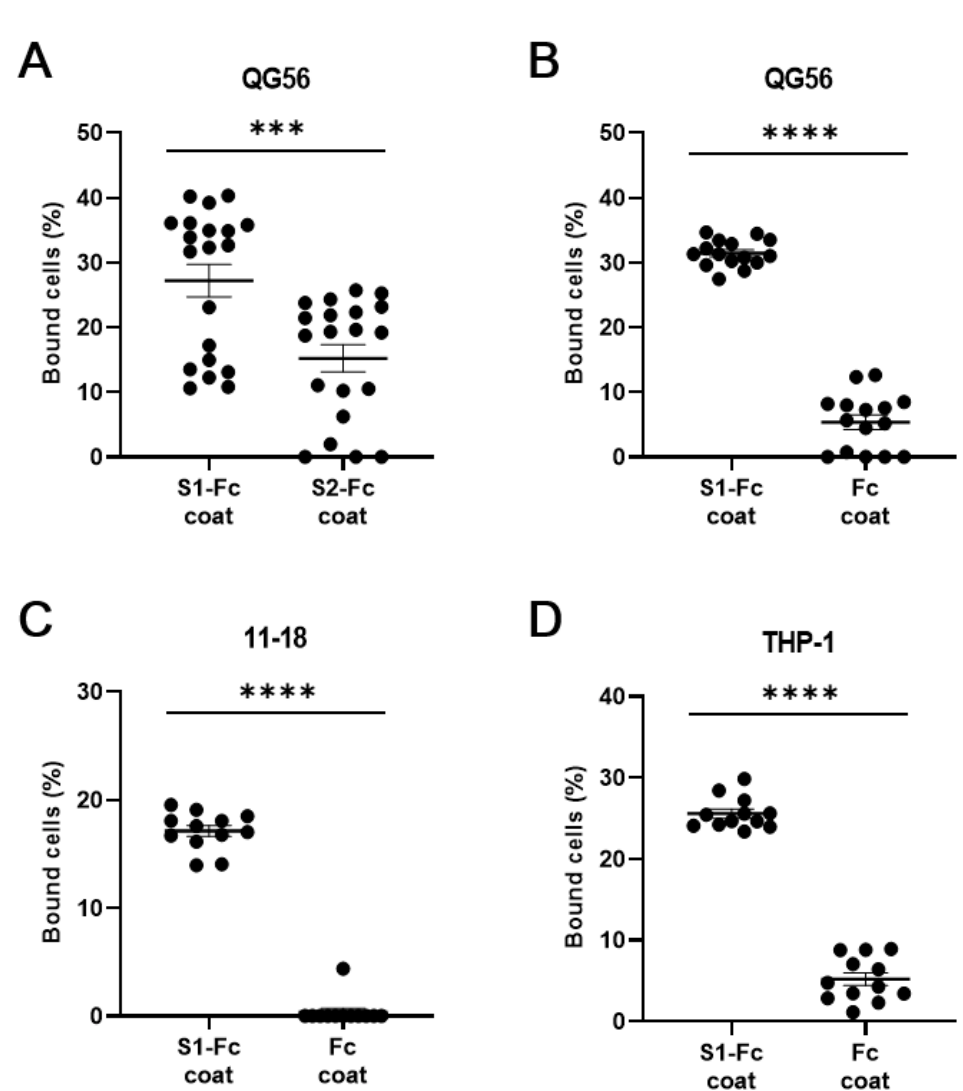
Figure 4. Binding of human lung epithelial cells and monocytes to S1-Fc. Cellular binding to S1-Fc was compared to S2-Fc ( A ) and to Fc alone ( B – D ). QG-56 ( A , B ), 11-18 ( C ), THP-1 ( D ) were used in this assay. Results are shown as column scatterplots overlayed with the mean ± SEM of at